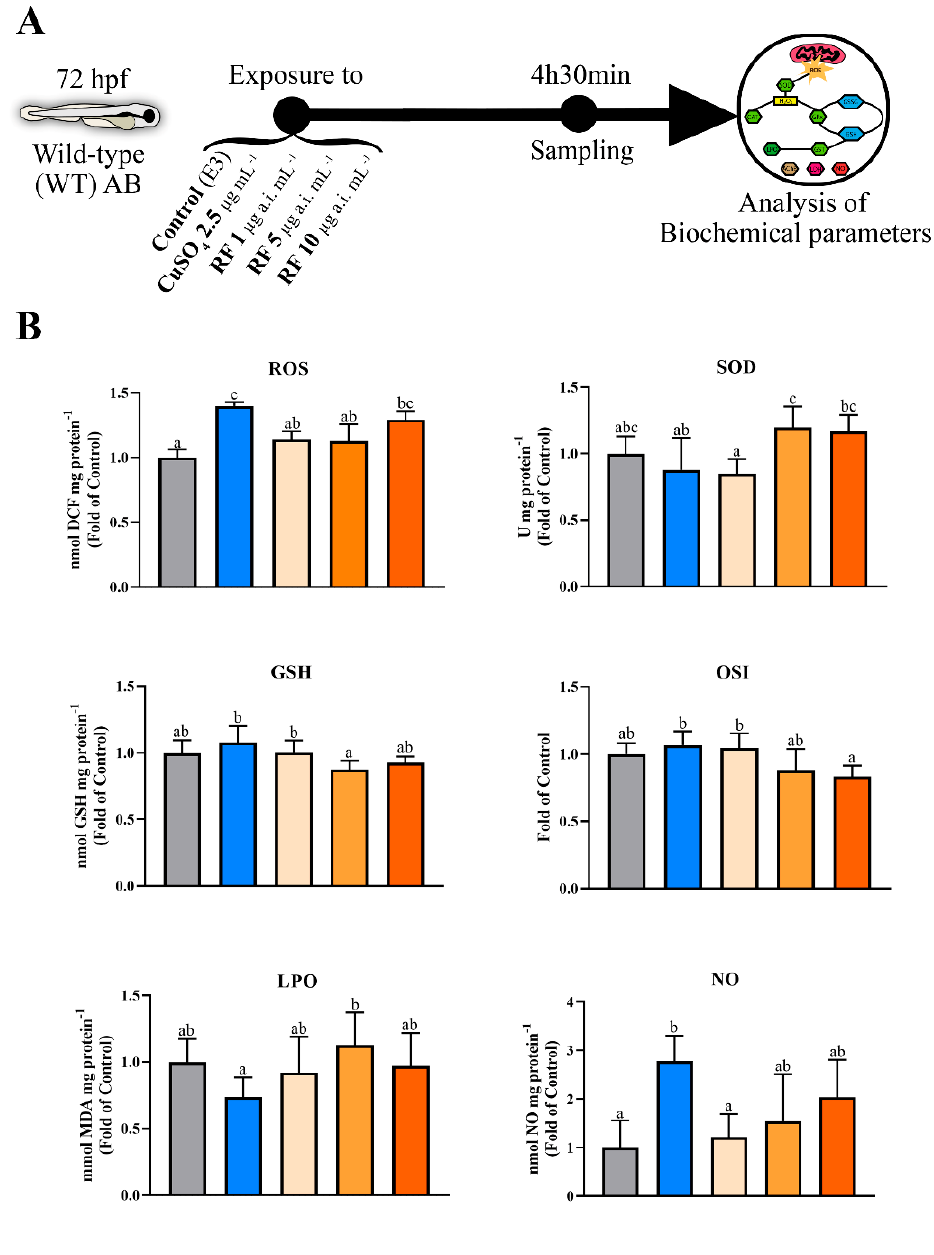
Figure 2. Effect of the different chemicals in biochemical parameters evaluated after exposure for 4 h 30 min in 72 hpf zebrafish WT larvae. Data from at least five independent samples of 50 random animals each. ( A ) Schematic diagram showing the study experimental protocol of biochemical parameters. ( B ) Graphs of biochemical parameters that showed significant differences after exposure to different chemicals. Values were normalised to the control group. Data are expressed as mean ± SD for parametric data distribution or median (interquartile range) for non-parametric data. Statistical analysis was performed using one-way ANOVA followed by Tukey’s multiple-comparison test or Kruskal–Wallis followed by Dunn’s test. Different letters represent statistical differences among treatment groups ( p <